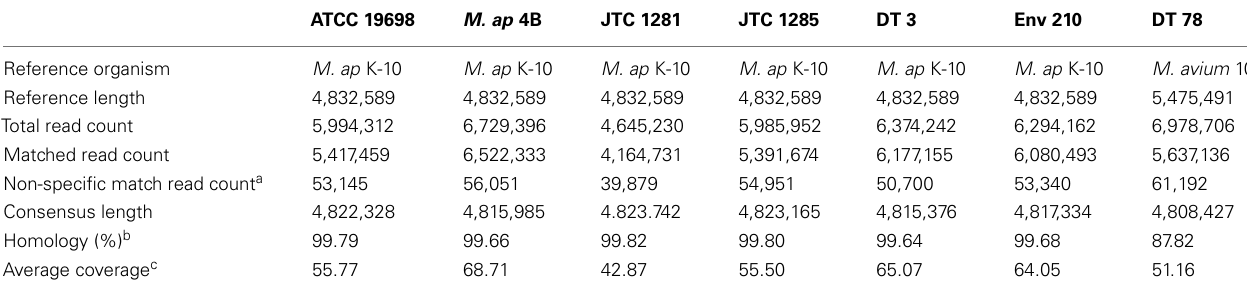
Table 2 |A summary report for CLC Bio reference assembly of M. avium and M. ap isolates.